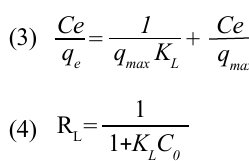
Table 1. Isotherm parameters for 2,4-D absorption using Fe